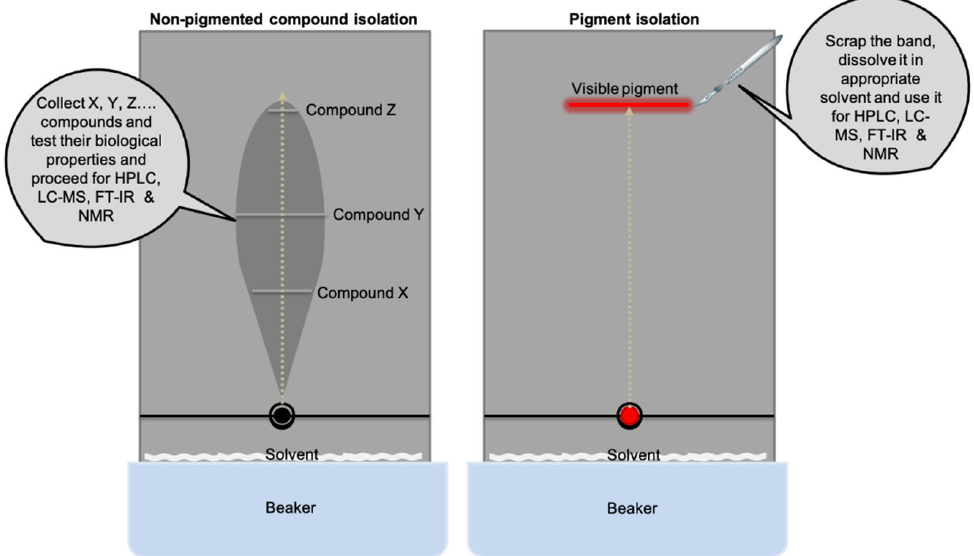
Figure 2. Illustration depicting the TLC technique as the easiest, rapid, effective, cheap, and time saving method to isolate and purify pigment molecules over non ‐ pigmented compounds.